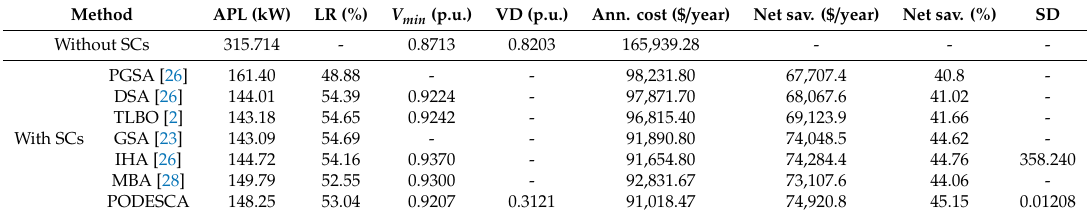
Table 8. Comparison of results between PODESCA and other methods for the 85-bus